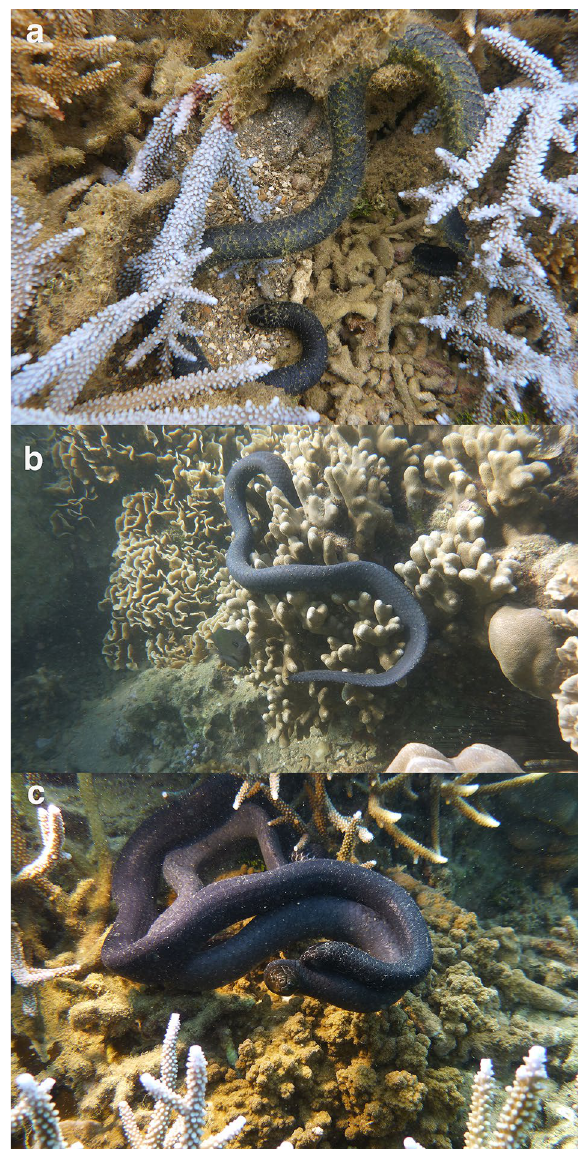
Figure 5. Turtle-headed sea snakes ( Emydocephalus annulatus ) in the Baie des Citrons, New Caledonia. The photographs show snakes ( a ) inactive, ( b ) feeding, and ( c ) courting. Photographs by Claire